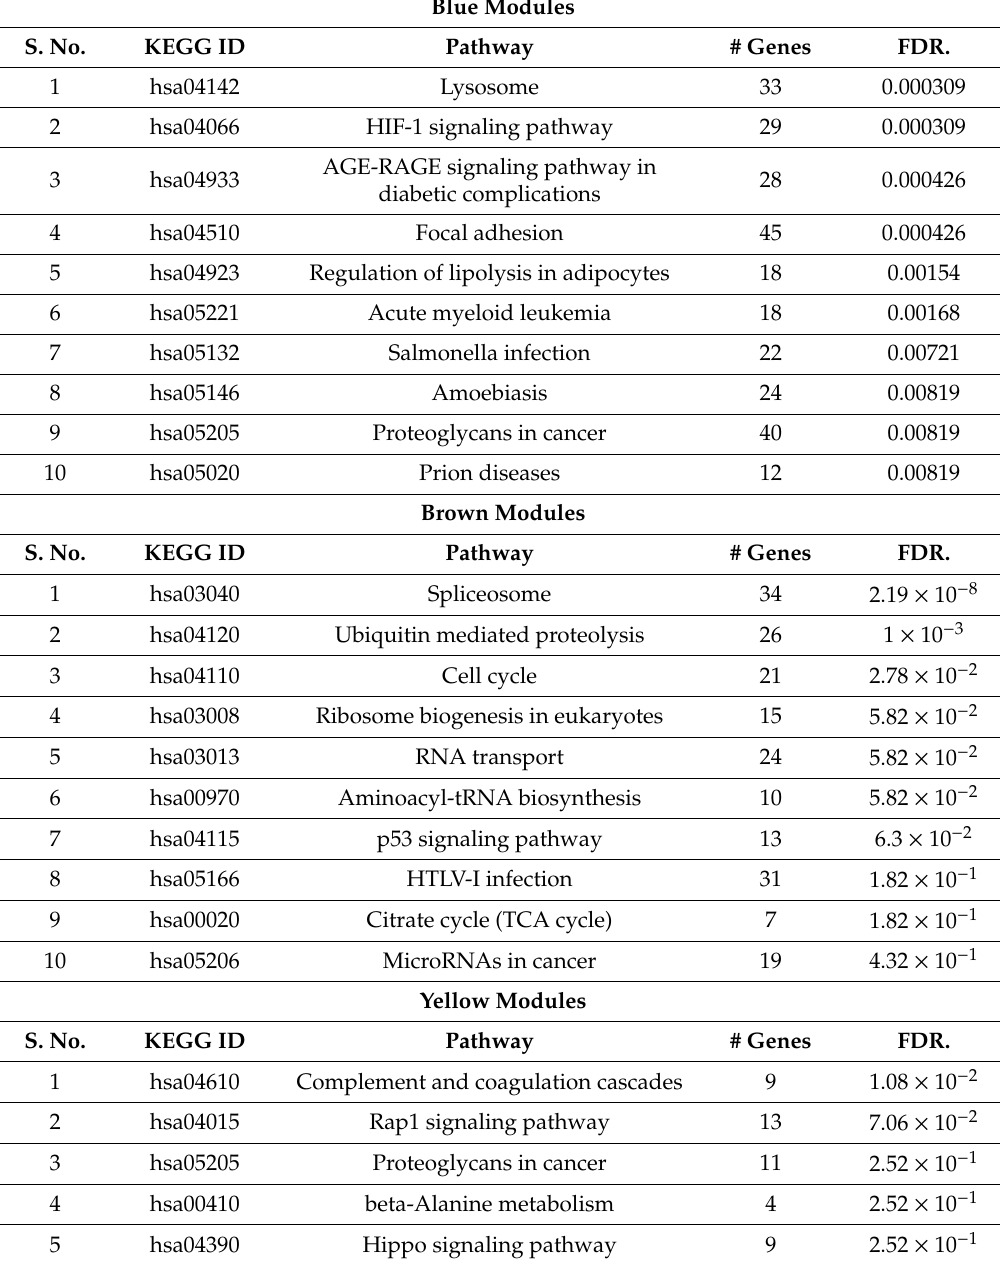
Table 11. Enriched KEGG pathways in relevant modules of visceral